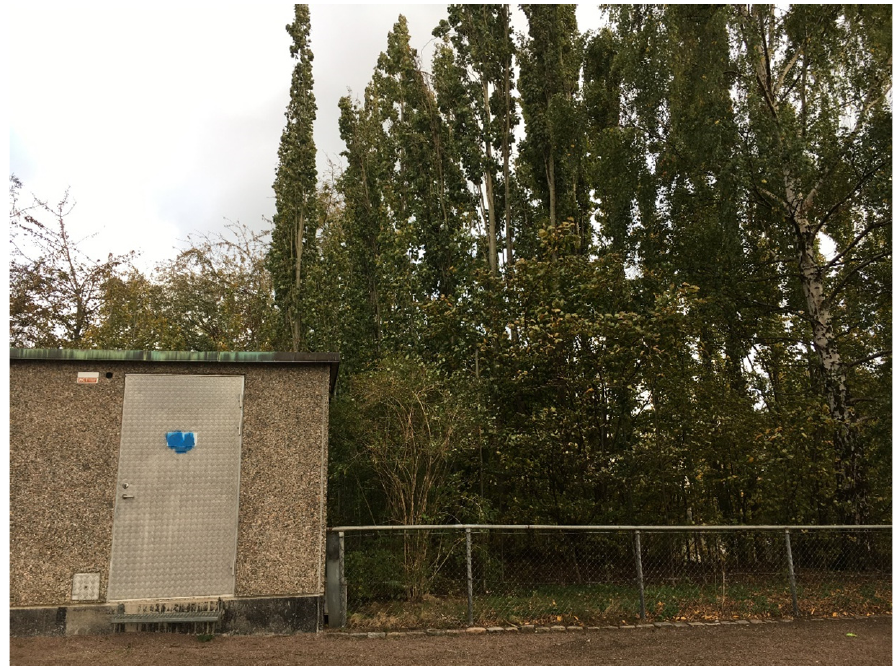
Figure 6. Adolescents suggested that the fence and electrical kiosk could be made more beautiful with vegetation cover or a happy colour.